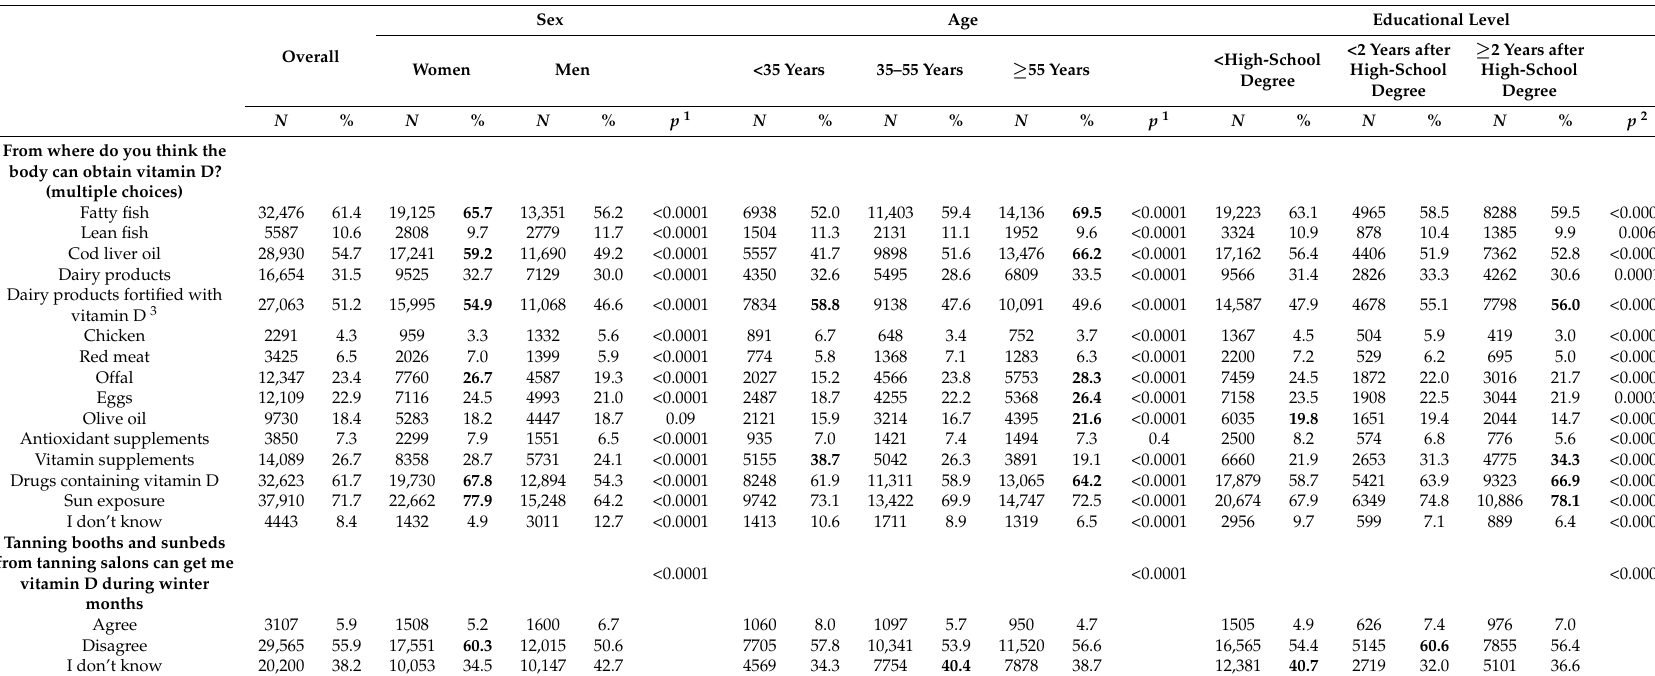
Table 4. Knowledge regarding sources of vitamin D overall and according to sex, age and educational level, NutriNet-Santé cohort, France